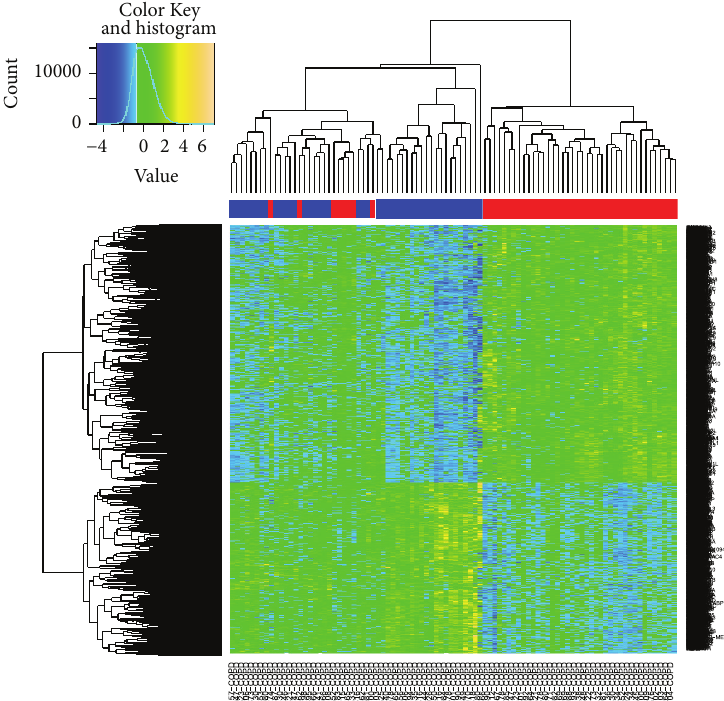
Figure 6: Heat map of RNA-seq results of lung tissues from COPD subjects. Hierarchical clustering of two subgroups in COPD subjects is shown.